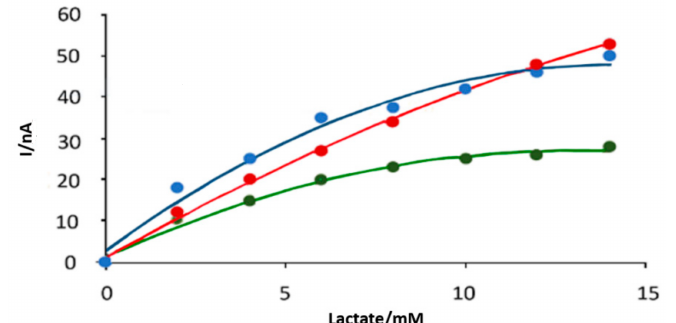
Figure 6. Lactate response in stirred PBS of planar ceramic electrode with polyurethane/SPEES PES covering layers designed for sweat monitoring. Calibration curve for three enzyme sources: 25 U/mg Pediococcus sp (blue circles); 161 U/mg Aerococcus viridans (red circles); 119 U/mg from Lactococcus lactis subsp. cremoris (green